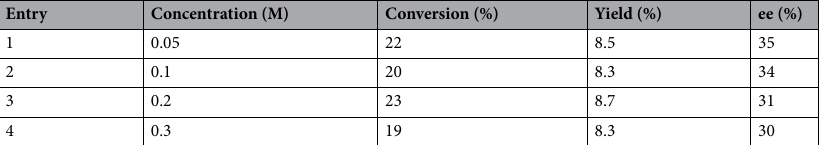
Table 3. Continuous flow elecrochemical screening of concentration reults with platinum as both the anode and cathode. Constant parameters: electrodes (Pt cathode/Pt anode), Temperature (rt), current (20 mA), charge (1.2 F/mol), flow rate (0.05 ml/min) and electrolyte (none). General procedure is followed as given above.